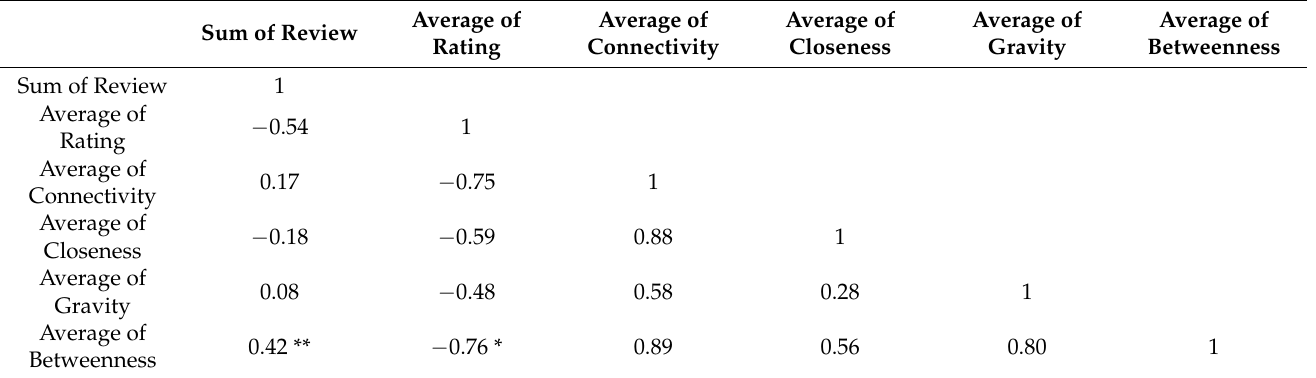
Table 11. Correlation of Digital Perception with 400-m Radius Area